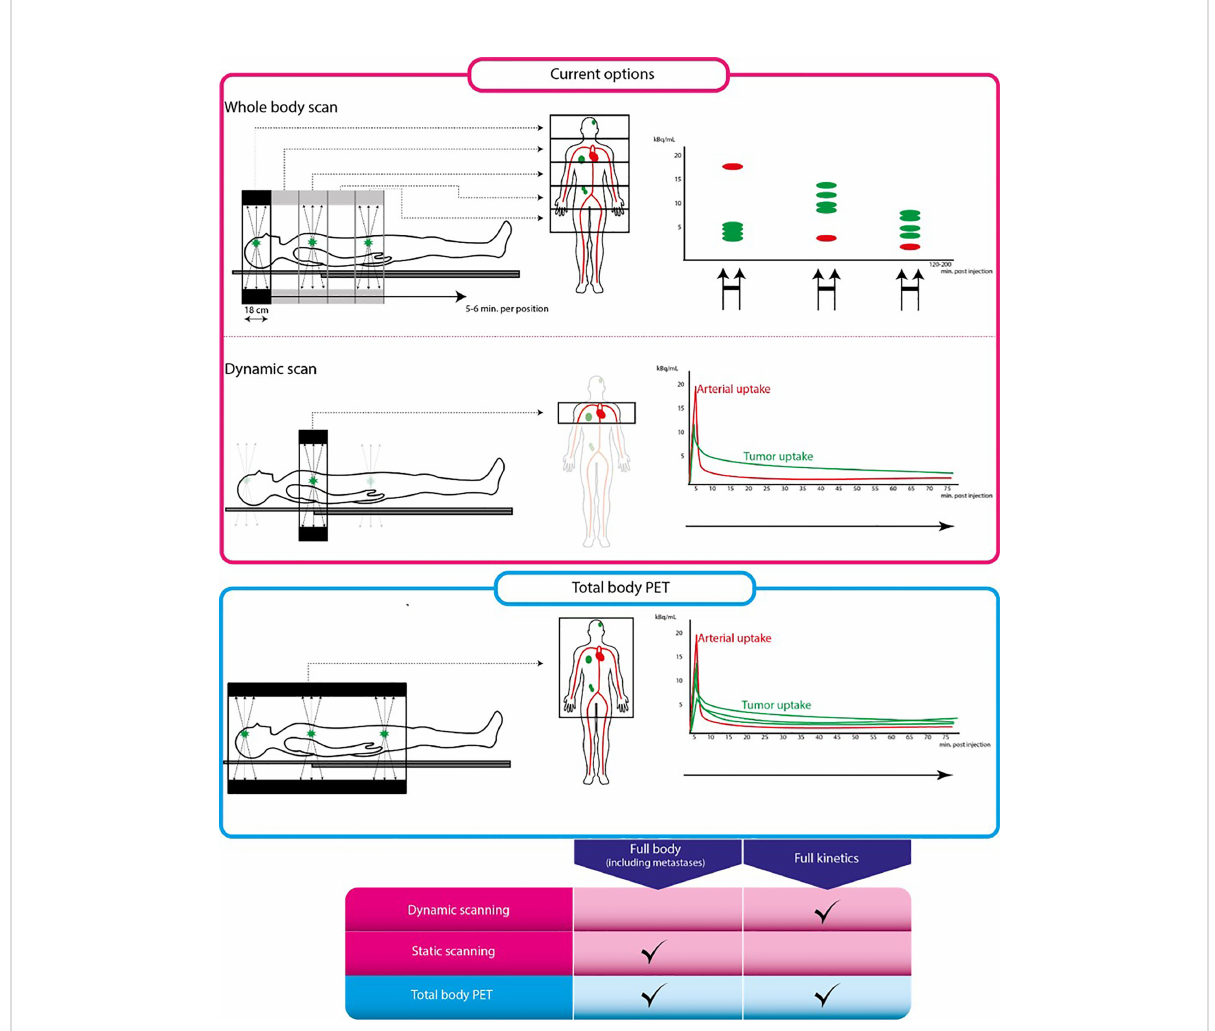
FIGURE 4 Conventional PET scan versus total body PET scan. From left to right: schematic representation of scan procedure, illustrations on the left are parts of the body that can be scanned using each scanning technique. Illustrations on the right are tracer uptake quanti fi cation differences for each technique. The pink box represent conventional PET scanning, the blue box represents total body PET. Table below shows characteristics of each scanning technique. Full kinetics indicates whether quanti fi cation using pharmacokinetic modeling is possible using this